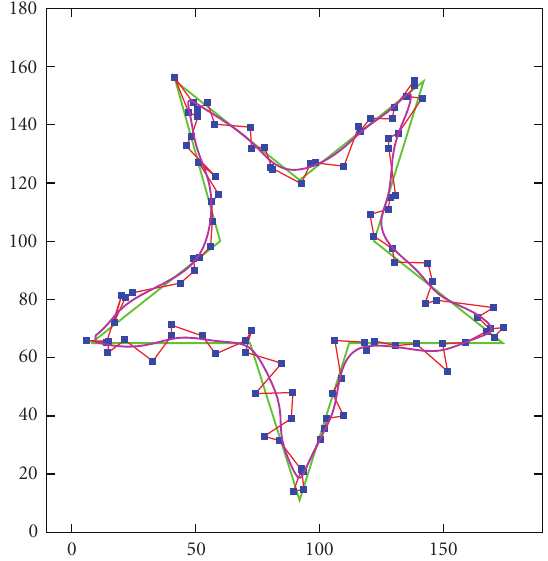
Figure 3: Recovery of the boundary of disk specified by 48 points with Gaussian noise of ν = 1 / 2 as in Figure 2.